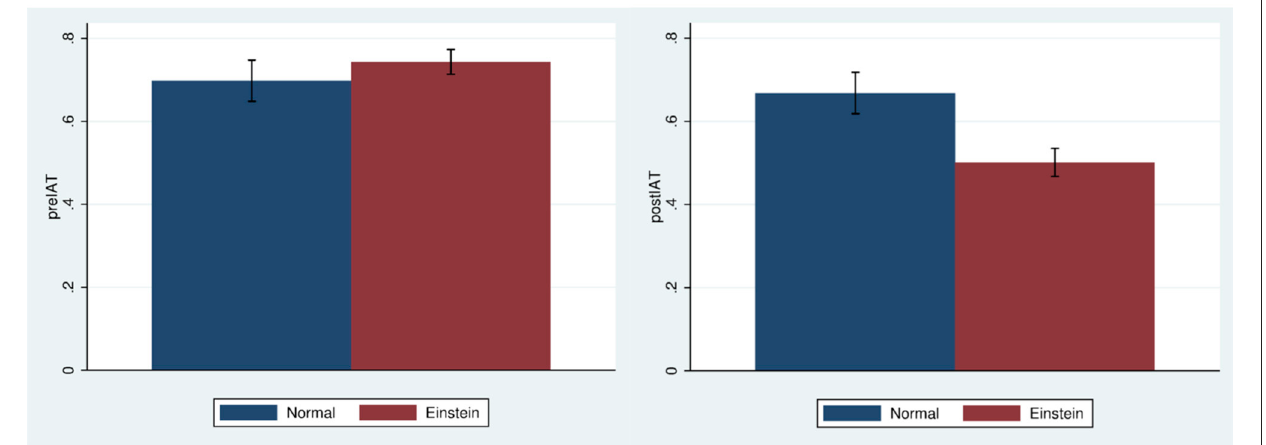
FIGURE 6 | Bar charts showing means and standard errors of preIAT and postIAT by Body.